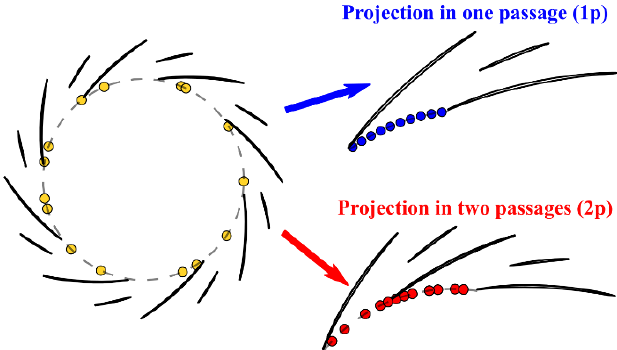
Figure 5. Projections of the steady pressure sensors at diffuser inlet .